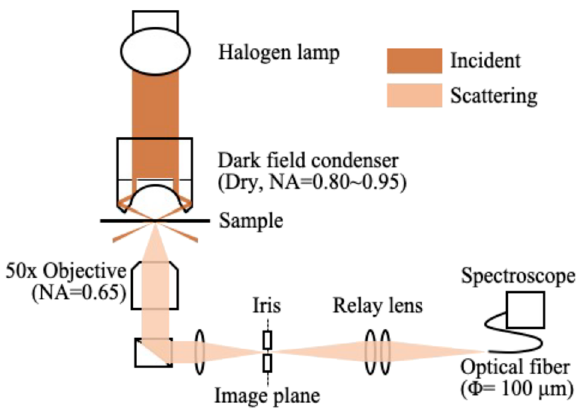
Figure 8: Configuration of the scattering spectroscopy measurement system.